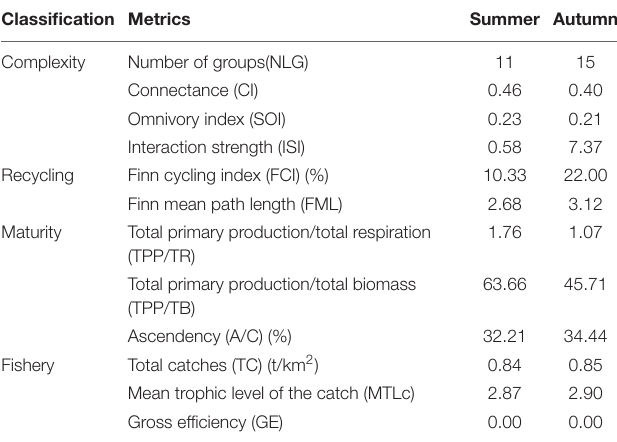
TABLE 2 | Food web trait metrics of artificial reef of Juehua Island in summer and autumn of 2019. Classification Metrics